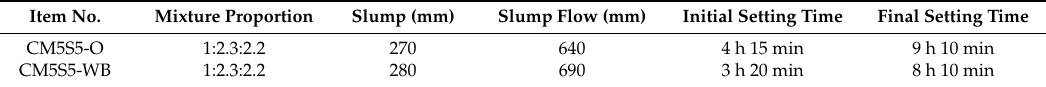
Table 7. Effect of recycled aggregate on the fresh properties of marble-based geopolymer concrete. Item No.